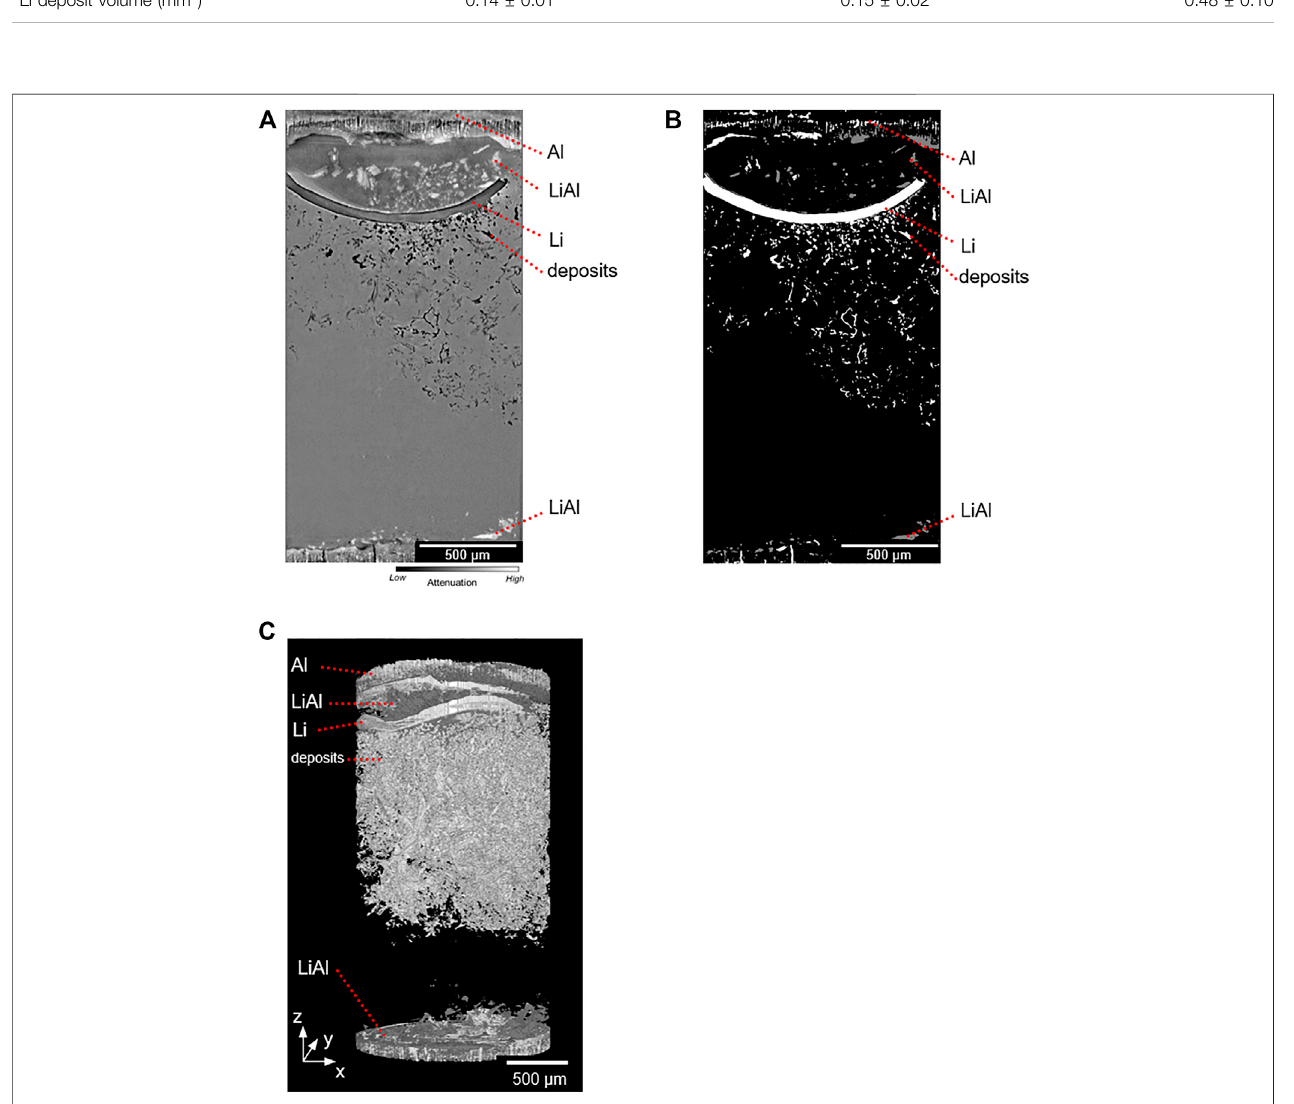
FIGURE5| Typical imageofthecycled 6 Li – LiCell_ A recordedat roomtemperaturefrom (A) synchrotron X-raytomographyimaging, (B) thesegmentedslice,and (C) volume rendering from the segmentation process.